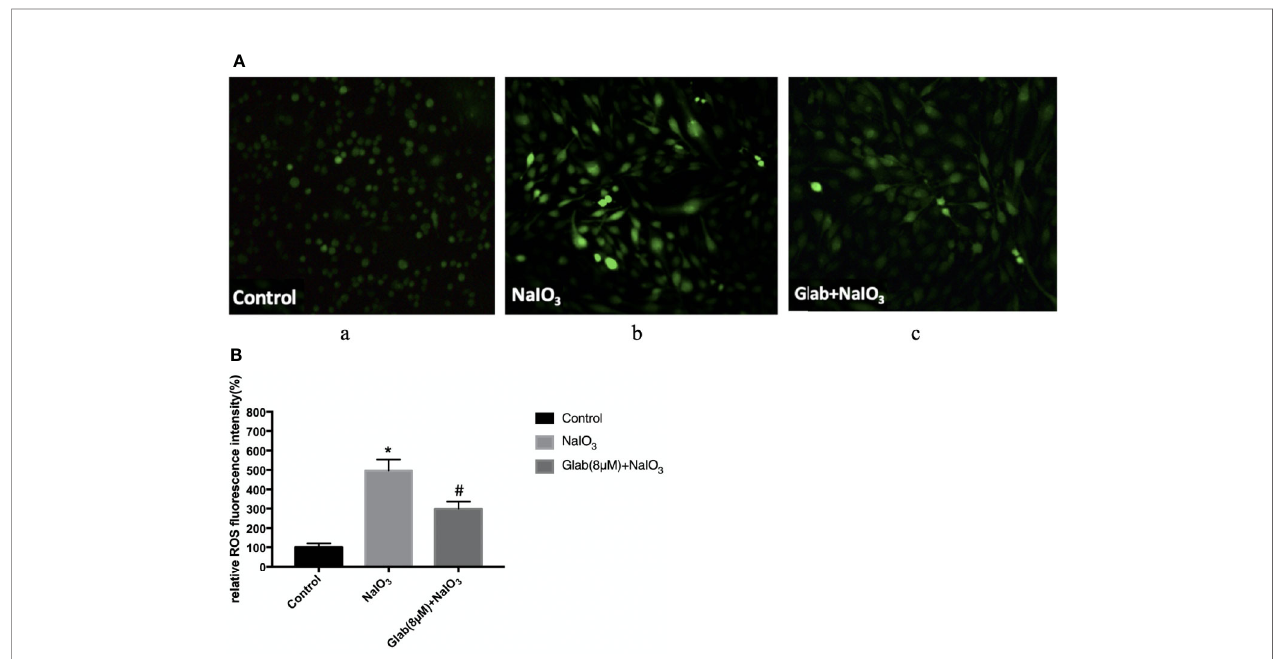
FIGURE 3 | Effects of Glabridin on the production of reactive oxygen species (ROS) in ARPE ‐ 19 cells treated with sodium iodate. (A) Dichloro ‐ dihydro ‐ fl uorescein diacetate (DCFH ‐ DA) staining of ARPE ‐ 19 cells after 24 h of sodium iodate and Glab treatment. a, retinal pigment epithelium (RPE) treated with DME-F12 (Control); b, RPE treated with sodium iodate(1200 m g/ml) (NaIO 3 ); c, RPE treated with Glabridin(8 m M) plus NaIO 3 (Glab(8 m M)+NaIO 3 ). (B) ROS levels were signi fi cantly increased in the